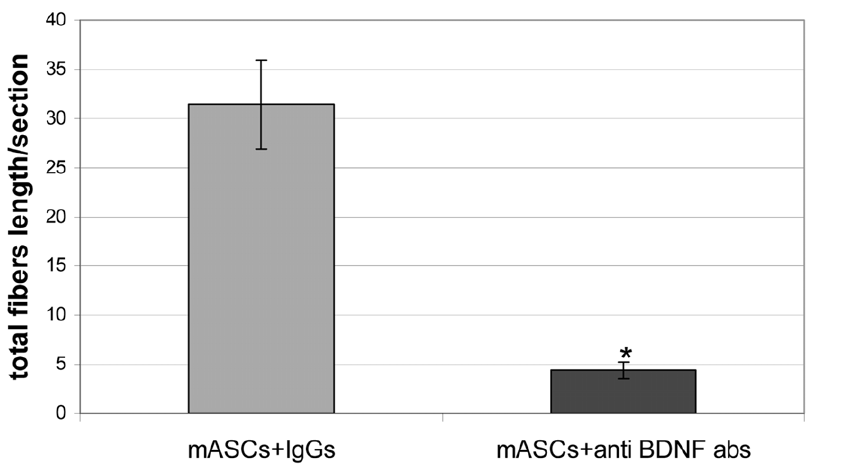
Figure 5. Total length of GAP43-positive nerve fibers in matrigel. Total length of nerve fibers per section was analyzed 10 days after transplantation using immunofluorescent staining with GAP43 antibodies of frozen sections of matrigel containing mASCs with 10 m g/ml non- specific IgGs (hatched column) or anti-BDNF neutralizing antibodies (grey column). * - p , 0,05.